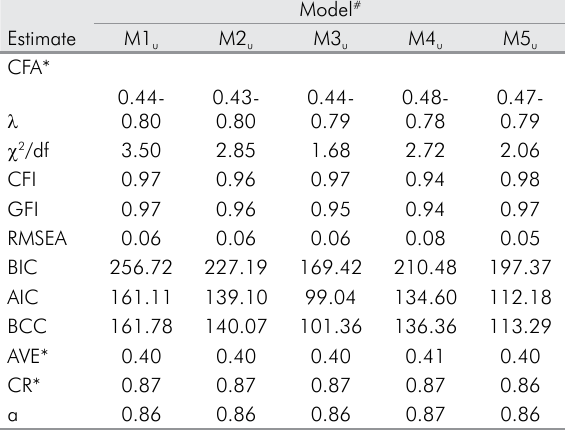
Table 3. Quality of adjustment indices of the confirmatory factor analysis (CFA), convergent validity (AVE), composite reliability (CR) of the unifactorial models adjusted to different samples and internal consistency (a) of the Geriatric/General Oral Health Assessment Index (GOHAI). Araraquara - SP / Brazil,